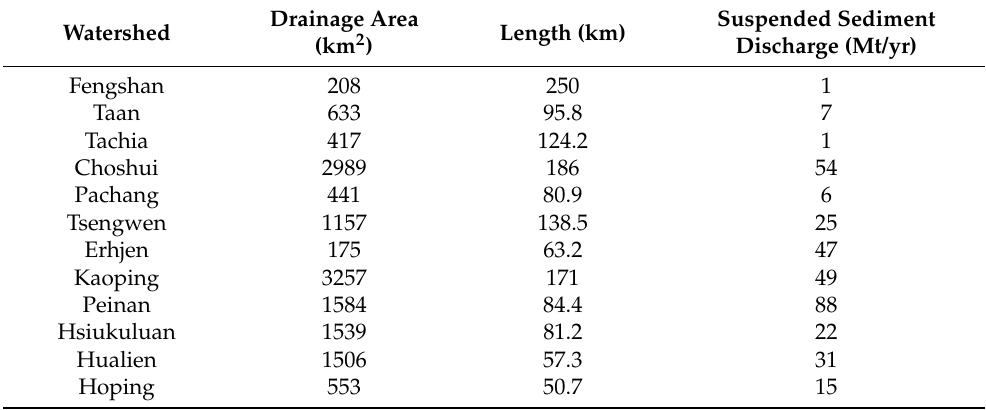
Table 1. Hyperpycnal discharges observed and predicted in Taiwan’s major coastal rivers. (Data from